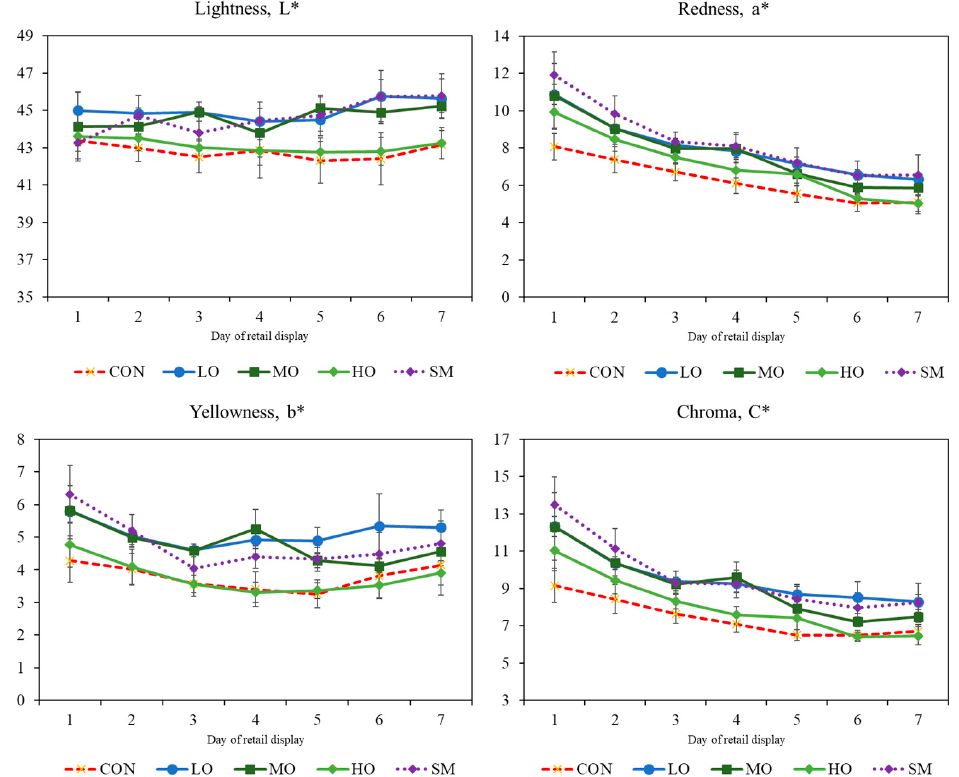
Figure 3. Colour coordinates (L* = lightness, a* = redness, b* = yellowness, and C* = Chroma. ± S.E.) in m. Longissimus lumborum of male lambs unsupplemented (CON) or supplemented with three different levels of oregano essential oils (LO = 0.2 g/kg of DM; MO = 0.3 g/kg of DM; or HO = 0.4 g/kg of DM) or monensin (SM), during 7 d of simulated retail display in modified atmosphere packaging (O2:CO2, 75:25%).